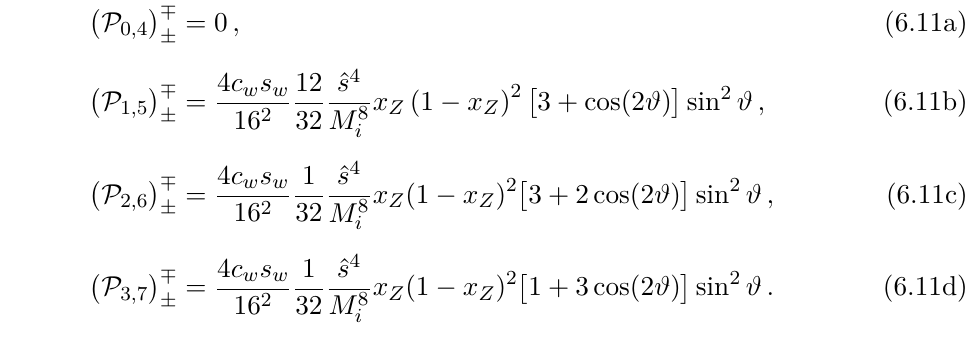
√ ˆ s = 100 GeV , where sizeable differences can , and in the limit Z ‘